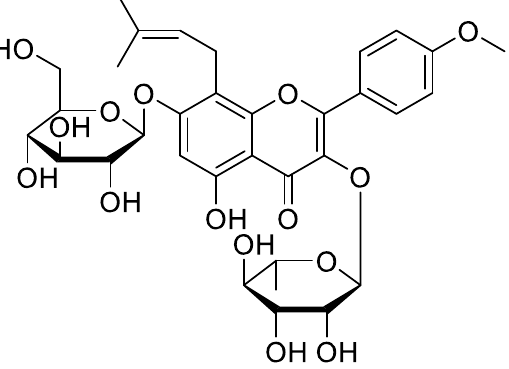
Figure 1: Chemical structure of